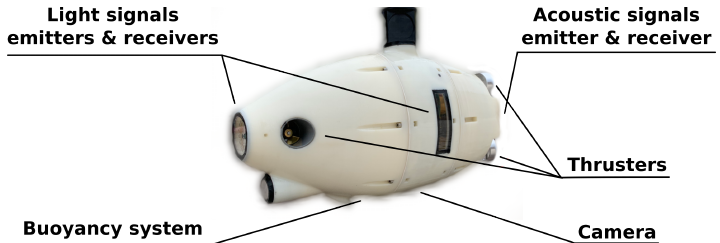
Figure 2. The aFish robot from the subCULTron project serves as a model for the simulated robots. It measures about 50 cm long, and 20 cm high. The main sensors and actuators used include thrusters (forward and backward motion, lateral rotation) and a buoyancy system for navigation. An acoustic transceiver is present for long range communication (<500 m) and modulated light transceivers disposed around the body are used for short range communication and perception of other robots (<0.5 m). A camera oriented towards the bottom allows for detecting target objects. In the simulations, the light transceivers are implemented with a perception cone to take into account range and aperture, and visual occlusions are not